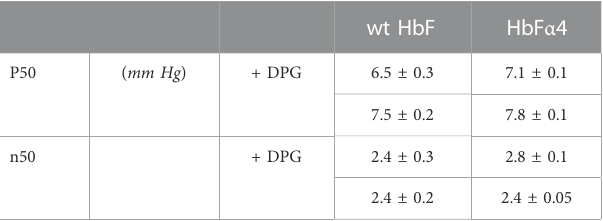
TABLE 4 Oxygen bidning characteristics of native and mutant